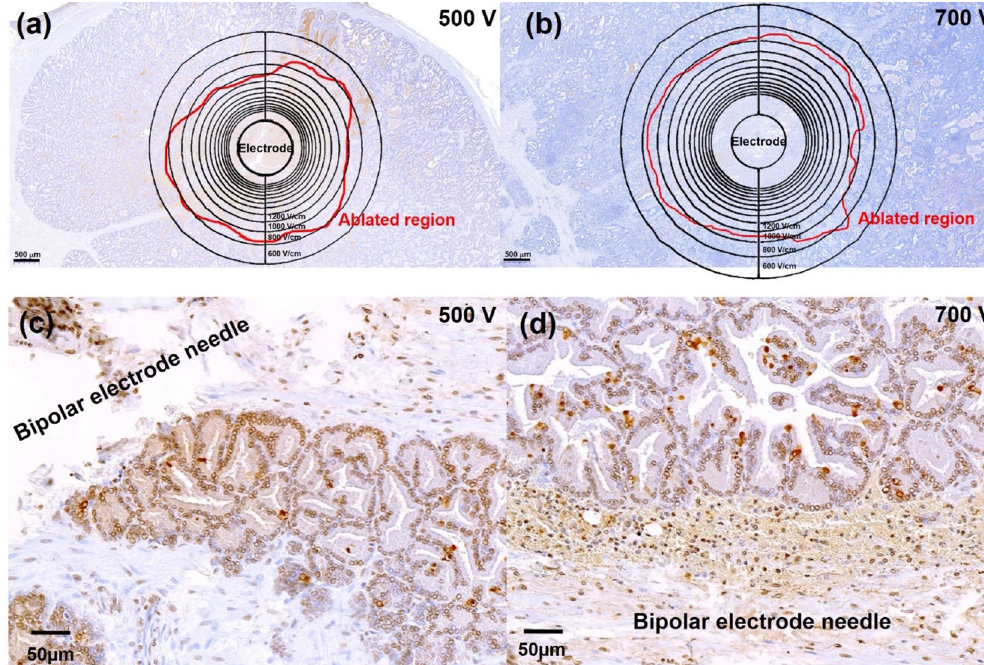
Figure 5. Microscopic images of TUNEL-stained slices following exposure to IRE at applied voltages of 500 V and 700 V. ( a ) Superposition of complete ablation, as determined by TUNEL assays, with isoelectric field strength curves in vertical sections of prostate tissues subjected to IRE at ( a ) 500 V and ( b ) 700 V. ( c , d ) TUNEL positive deposition following exposure to IRE at both ( c ) 500 V and ( d ) 700